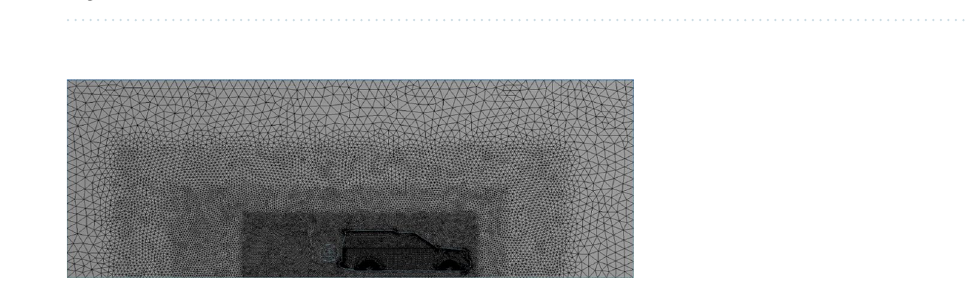
Figure 6. Three VCBs around the car.